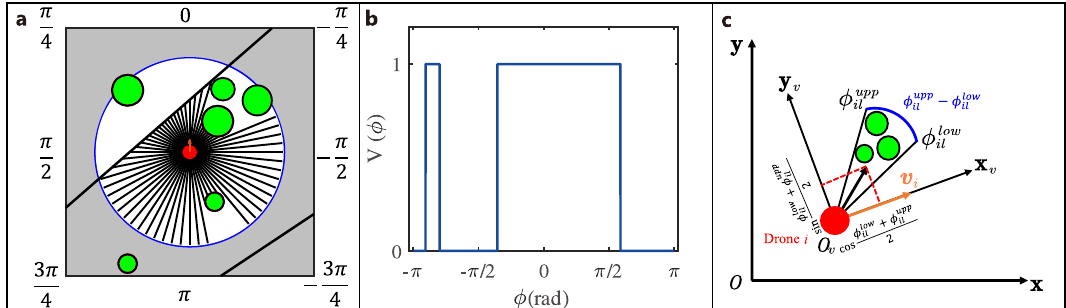
Fig.3 Schematic diagram of the drone using visual mechanism to per- ceive the environment. a The field of view projection of the drone. The black square represents the unknown environment. The red disk in the center of the square represents the i -th drone, and its line of sight is a solid black line evenly distributed around it. The blue circle repre- sents the range of vision of the drone, with a radius r vis . The gray area indicates that it is out of the line of sight. The six green disks and the two solid black lines through the grey area represent obstacles and walls